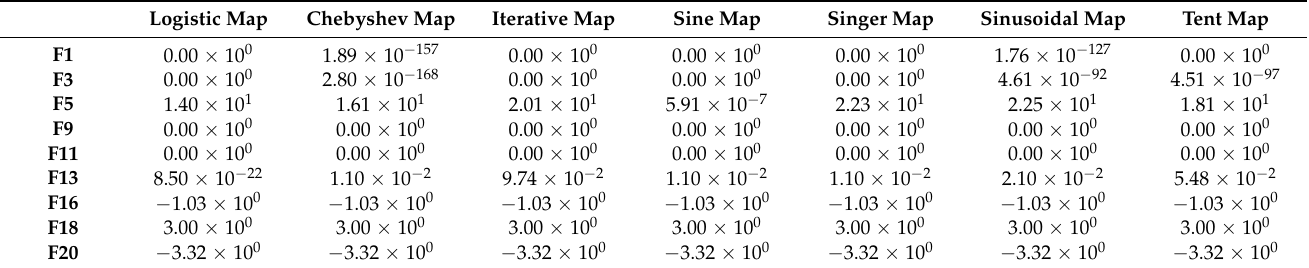
Table 3. Fitness values of FDA optimized by seven chaotic functions on nine benchmark